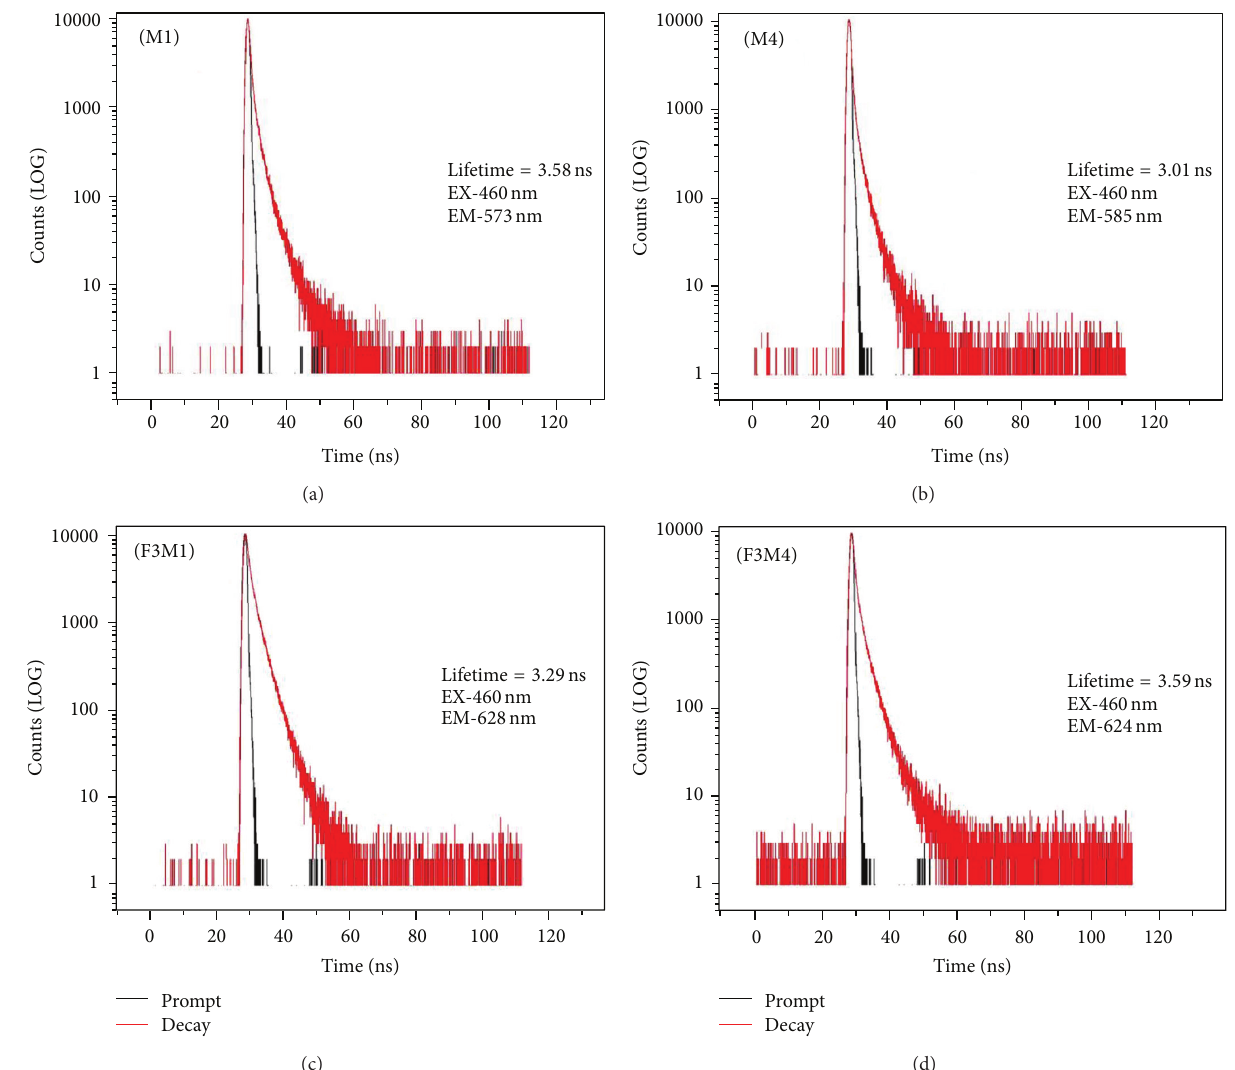
Figure 7: Photoluminescence decay curves of M1, M4, F3M1, and F3M4